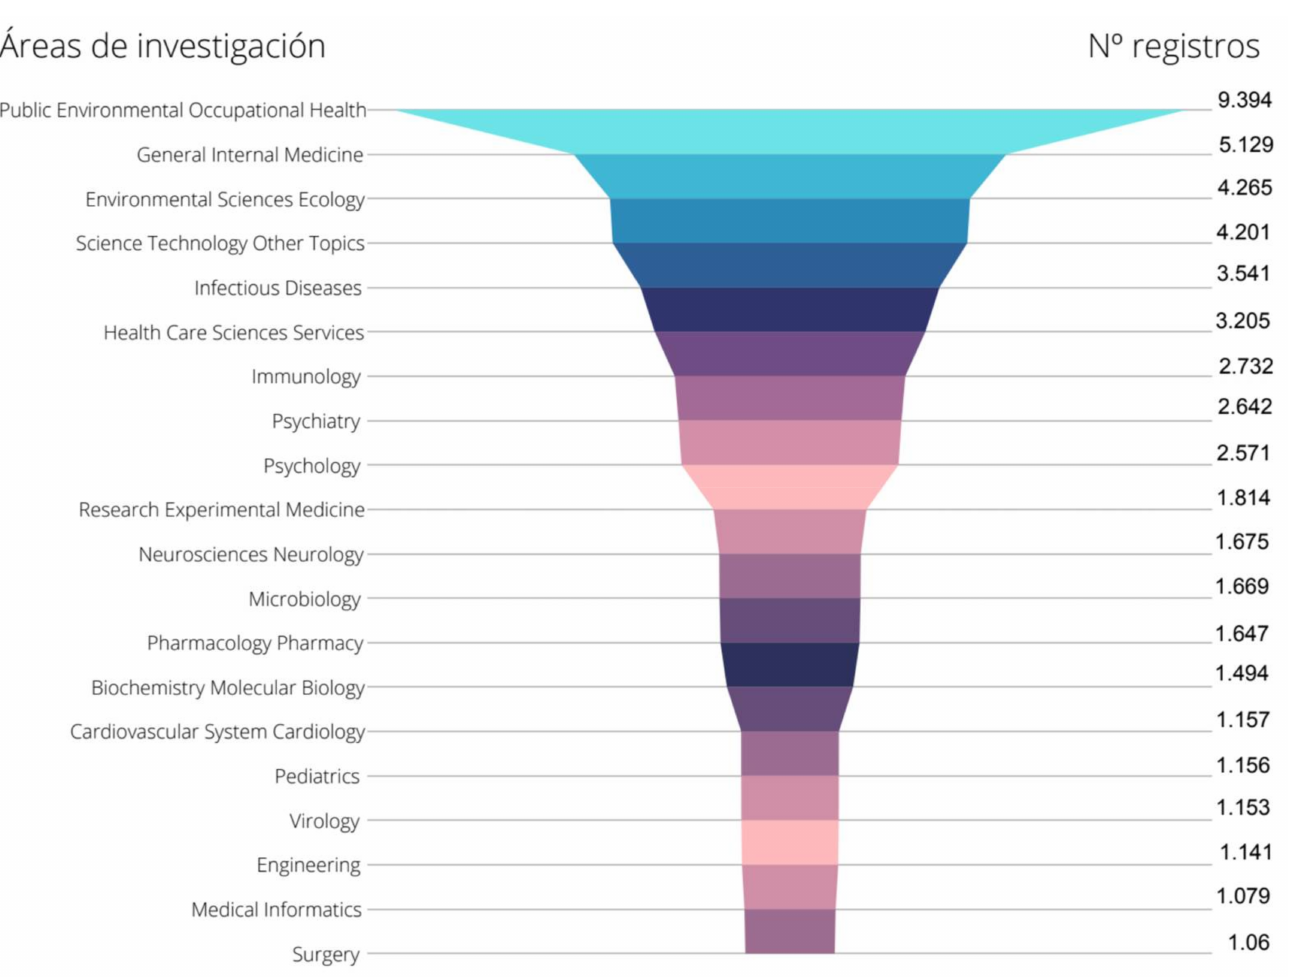
Figure 3. Research fields and records by category over the total number of analysed articles of COVID-19 and